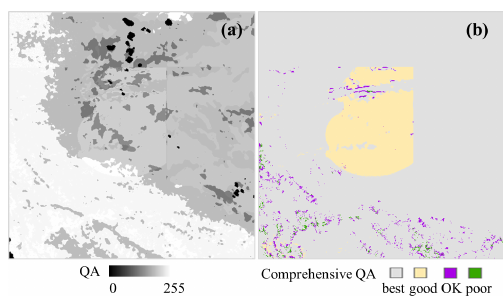
Figure A1. The QA maps over Taklimakan Desert on 19 Jan- uary 2008. The QA map (a) . Comprehensive QA map (b) .